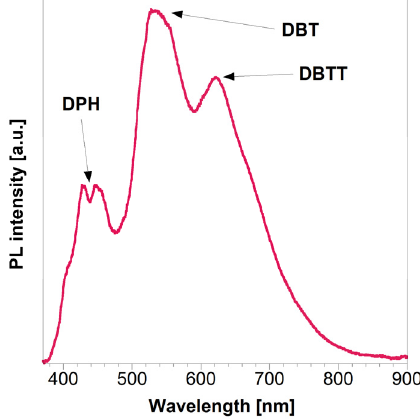
Figure 2. PL emission spectrum of a DCA-DPH:DBT:DBTT spin-coated film without any additives, with DPH:DBT:DBTT molar ratios of 96.9:2.9:0.2. The sample was excited at 360 nm.